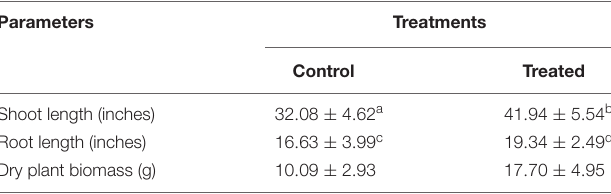
TABLE 1 | Effect of D. cinnamea 55 inoculation on the growth of corn plants (pot